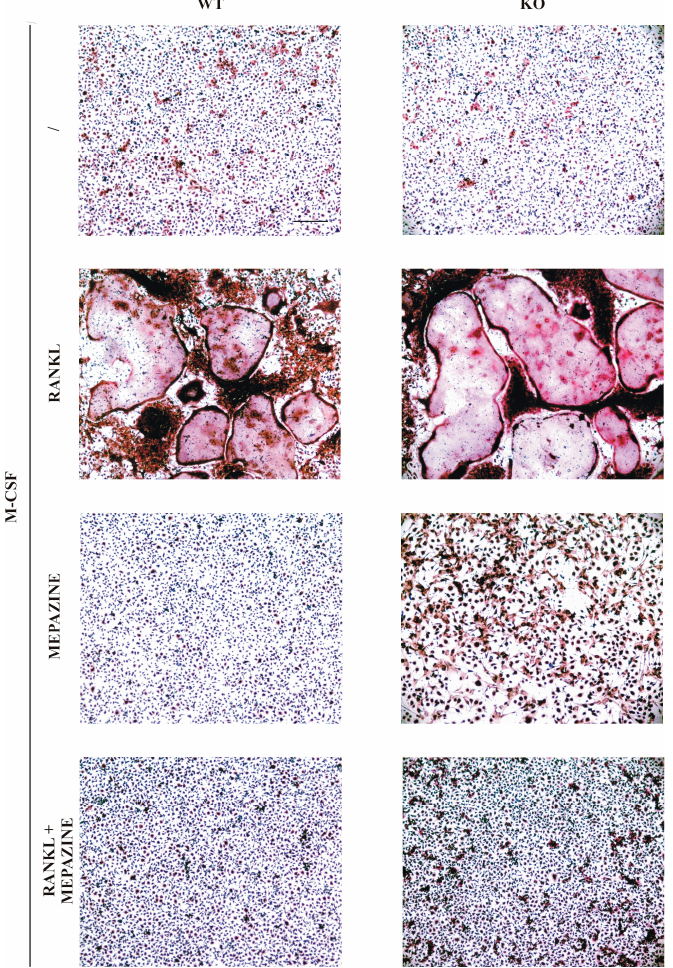
Figure 1. Mepazine inhibits RANK ligand (RANKL)-induced osteoclastogenesis independently of mucosa-associated lymphoid tissue lymphoma translocation (MALT1). Bone marrow cells (BMCs)